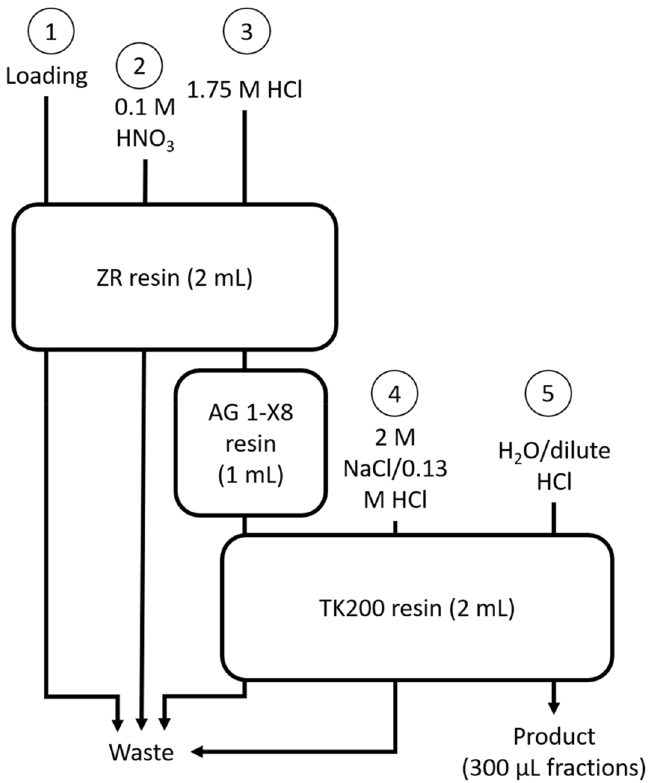
Figure 6. Three column approach for isolating [ 66 Ga]GaCl 3 . Process steps described below. (1) The diluted solution was loaded at a rate of ~ 1.5 mL/min over a 2 mL ZR column, whereby 66 Ga is retained on the resin, and the irradiated 66 Zn was passed through to a collection vial for optional recycling. During the irradiation, coproduced 13 N is passed through in this step as well. (2) The ZR resin was rinsed with 14 mL of 0.1 M HNO 3 to remove residual 66 Zn. (3) The 66 Ga was eluted from the ZR resin with 5 mL 1.75 M HNO 3 , passed over a 1 mL AG 1-X8 column to remove residual trace metals, before being trapped on a TK200 column. (4) The TK200 column was rinsed with 3.5 mL 2 M NaCl in 0.13 M HCl to decrease residual acid on the column. (5) Finally, the 66 Ga, as [ 66 Ga]GaCl 3 was eluted from the TK200 resin in nominal 300 μL fractions, the first 3.5 mL of which was water, followed by 2.5 mL 0.18 M HCl. The fraction(s) with the highest radioactivity concentration(s) were used for